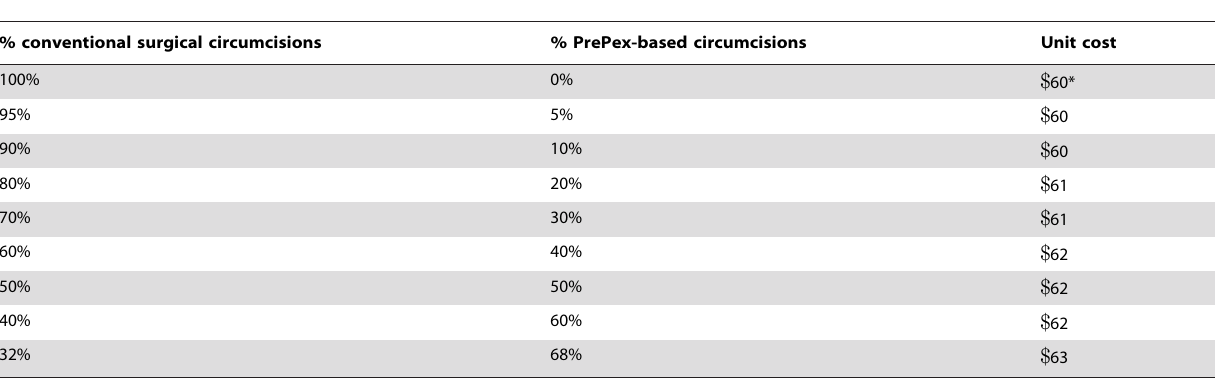
Table 2. Effect of proportion of conventional surgical versus PrePex-based circumcisions on unit cost at the mixed study site.